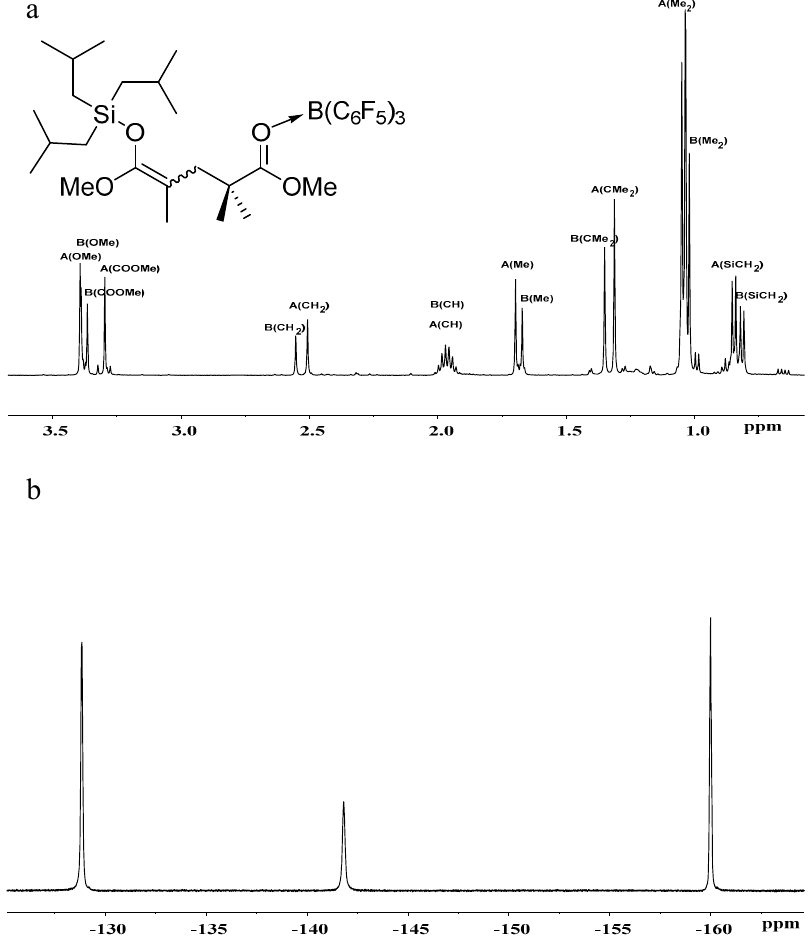
Figure 4. ( a ) 1 H- and ( b ) 19 F-NMR spectra of i Bu 3 SiO(OMe)C=C(Me)CH 2 CMe 2 C(OMe)=O···B(C 6 F 5 ) 3 .